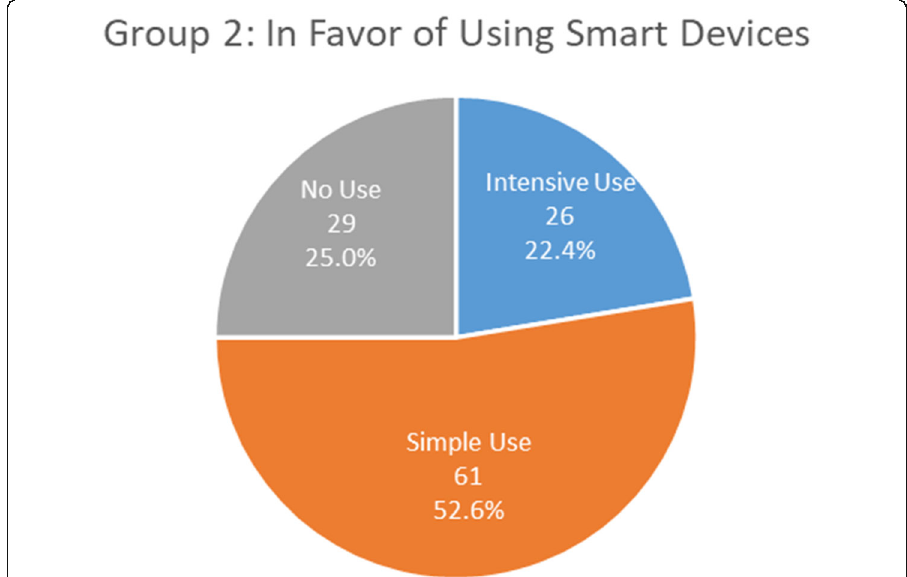
Fig. 5 Classification of instructors in favor of using smart devices